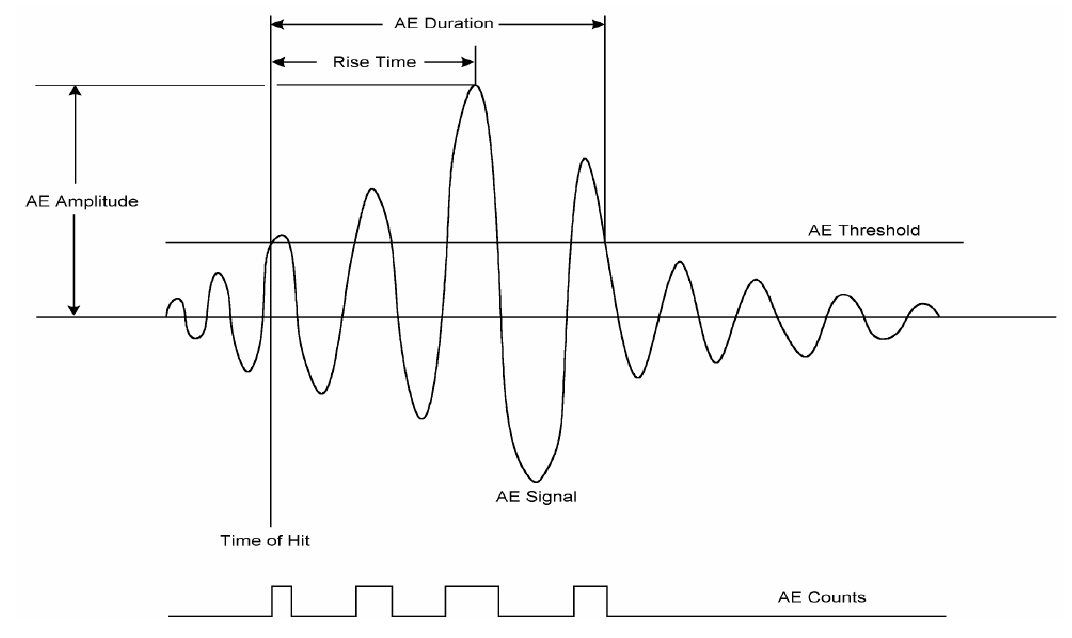
Figure 8. A typical acoustic emission signal diagram.